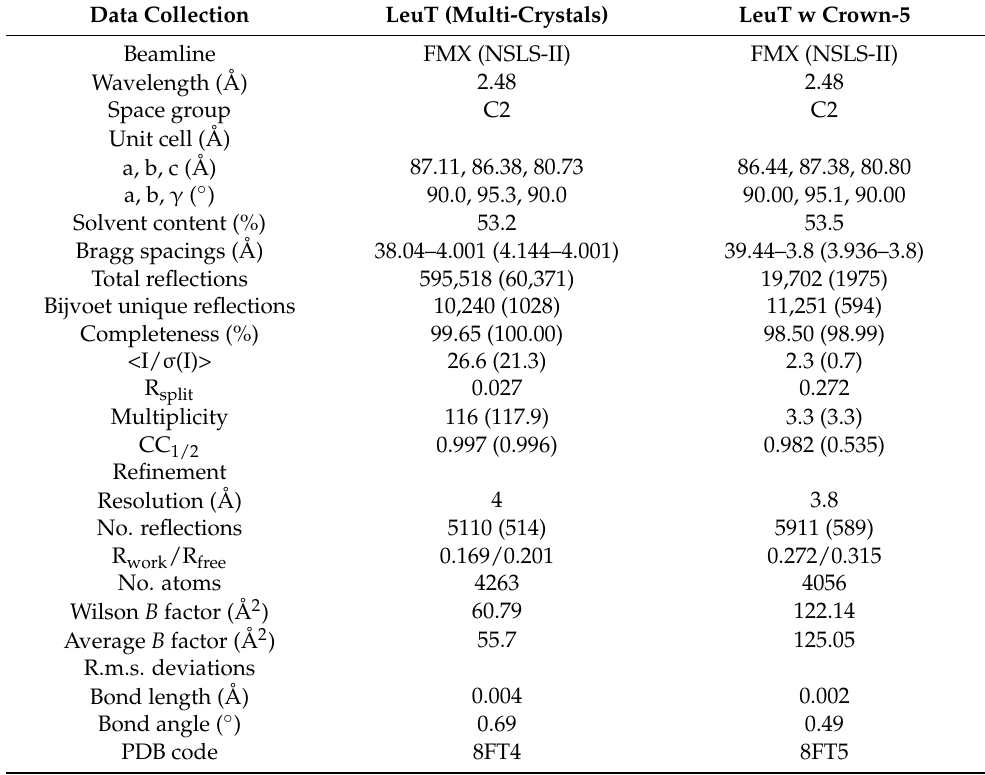
Table 1. Data collection and refinement